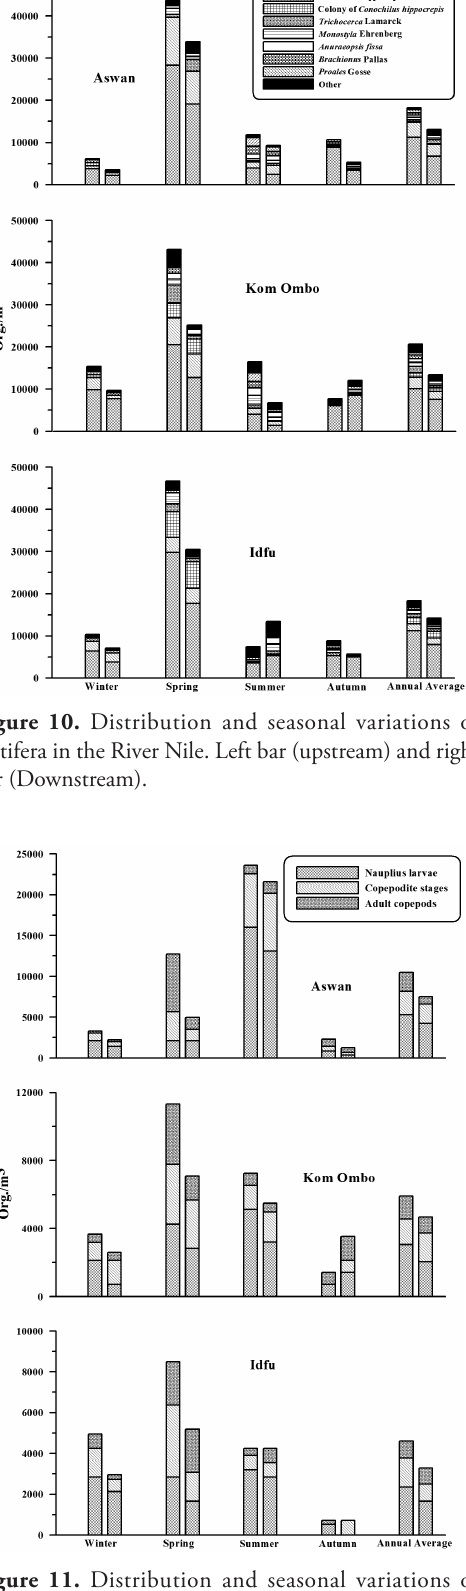
Figure 11. Distribution and seasonal variations of Copepoda in the River Nile. Left bar (upstream) and right bar (Downstream).